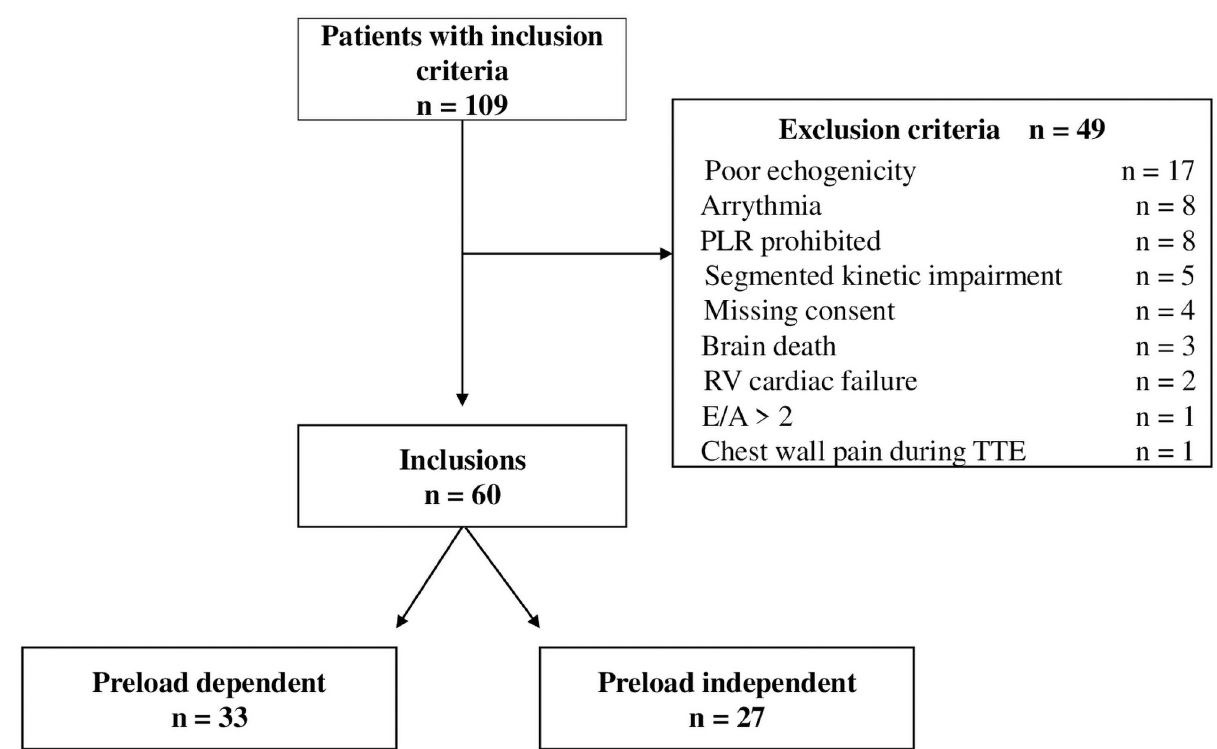
Fig 2. Flow chart. PLR: passive leg raising maneuver, RV: right ventricle, LV: left ventricle, TTE: trans-thoracic echocardiography.